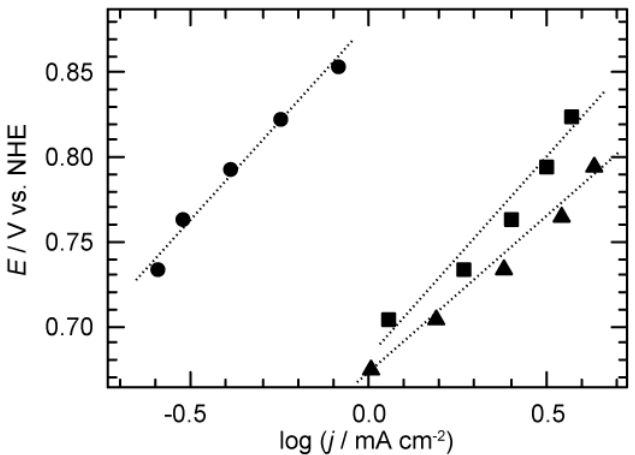
Figure 2. Tafel plot of logarithm total current density (log( j total )) versus electrochemical potential ( E ) under oxygen evolution condition from F–carbon. The data were recorded in pH 13 (circle), pH 13.5 (square) and pH 14 (triangle). Current density was averaged throughout at each potential step.